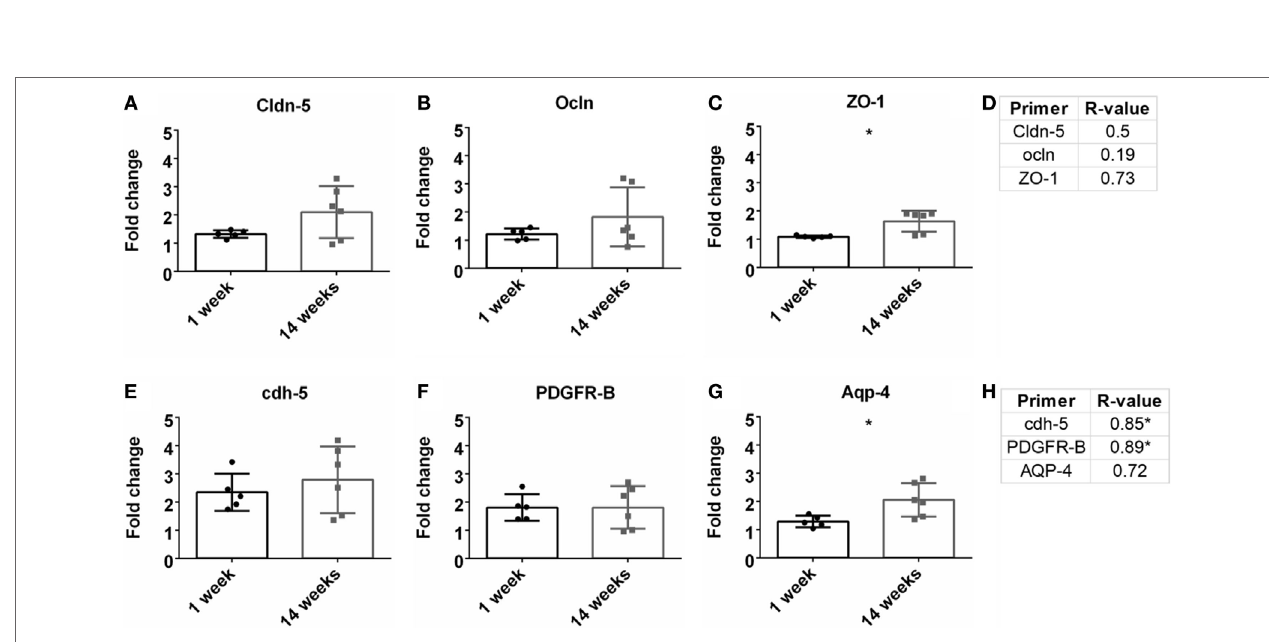
FigUre 4 | Fold change comparisons between 1 and 14 weeks for M1-like pro-inflammatory markers (a) CD32, (b) CD64, (c) CD80, (D) CD86, and (e) CCR7, and M2-like anti-inflammatory markers (F) CD206, (g) CD163, and (h) Arg-1 (* p < 0.05, Student’s t -test, Bonferroni corrected). Each time point was compared to age-matched naïve controls to calculate fold change. Pearson correlations for (i) M1-like and (J) M2-like markers (* p <